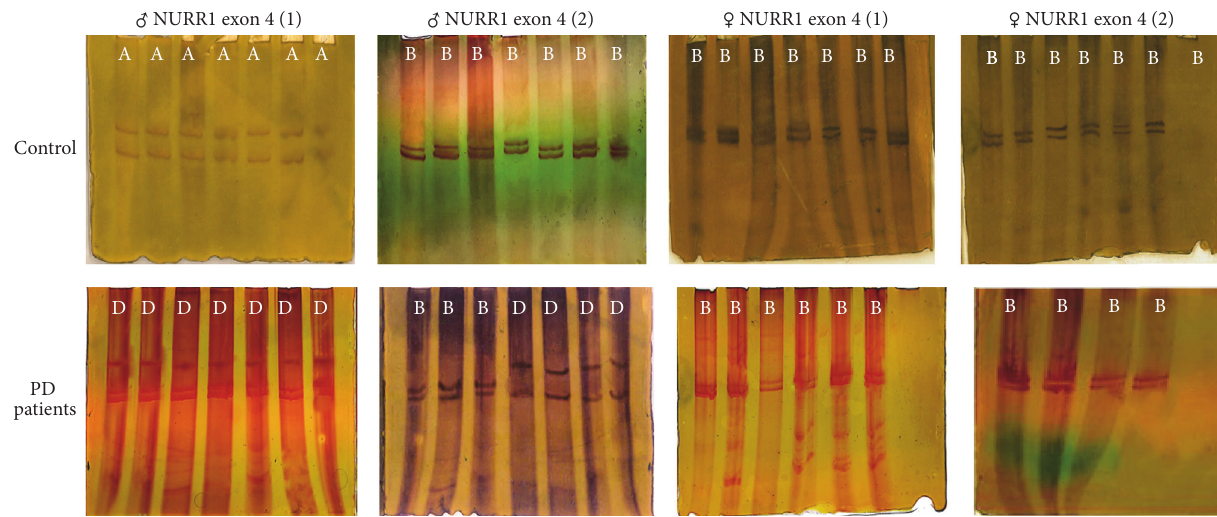
Figure 4: Representative SSCP analyses for exon 4 of the NURR1 gene in male and female PD patients. The exon was divided into two reactions: 1 and 2. A, B, and D represent conformational patterns of the bands found.